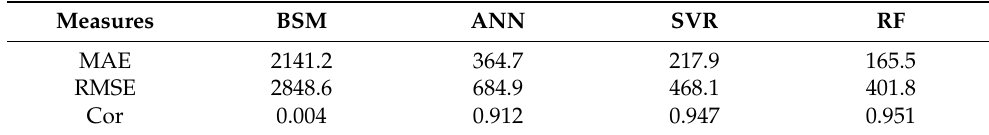
Table 5. Summary of option